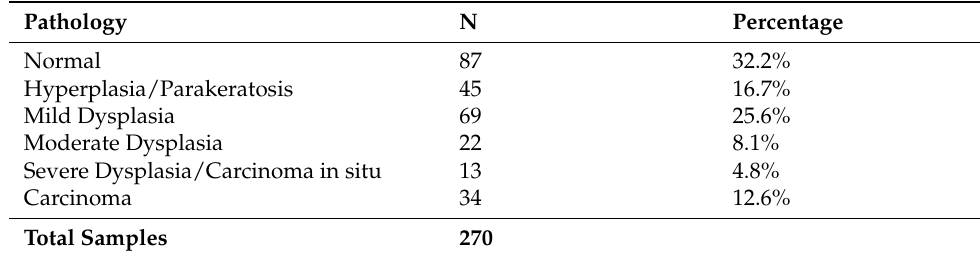
Table 2. Pathology distribution of samples.